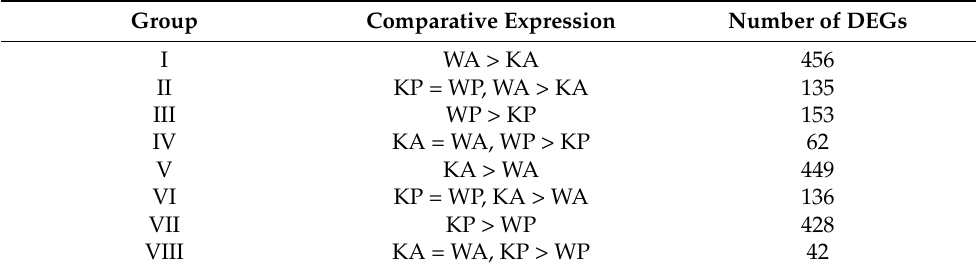
Grouping comparative expression levels and number of differentially expressed genes